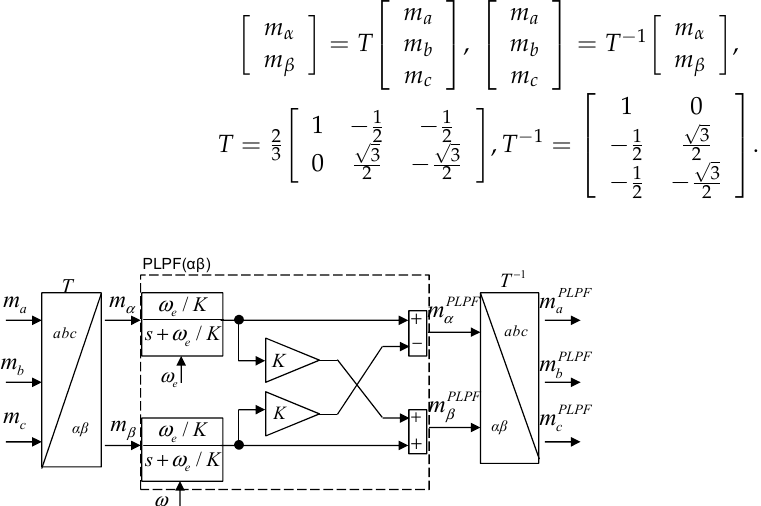
Figure 2. The conventional PLPF to obtain filtered three-phase variables.